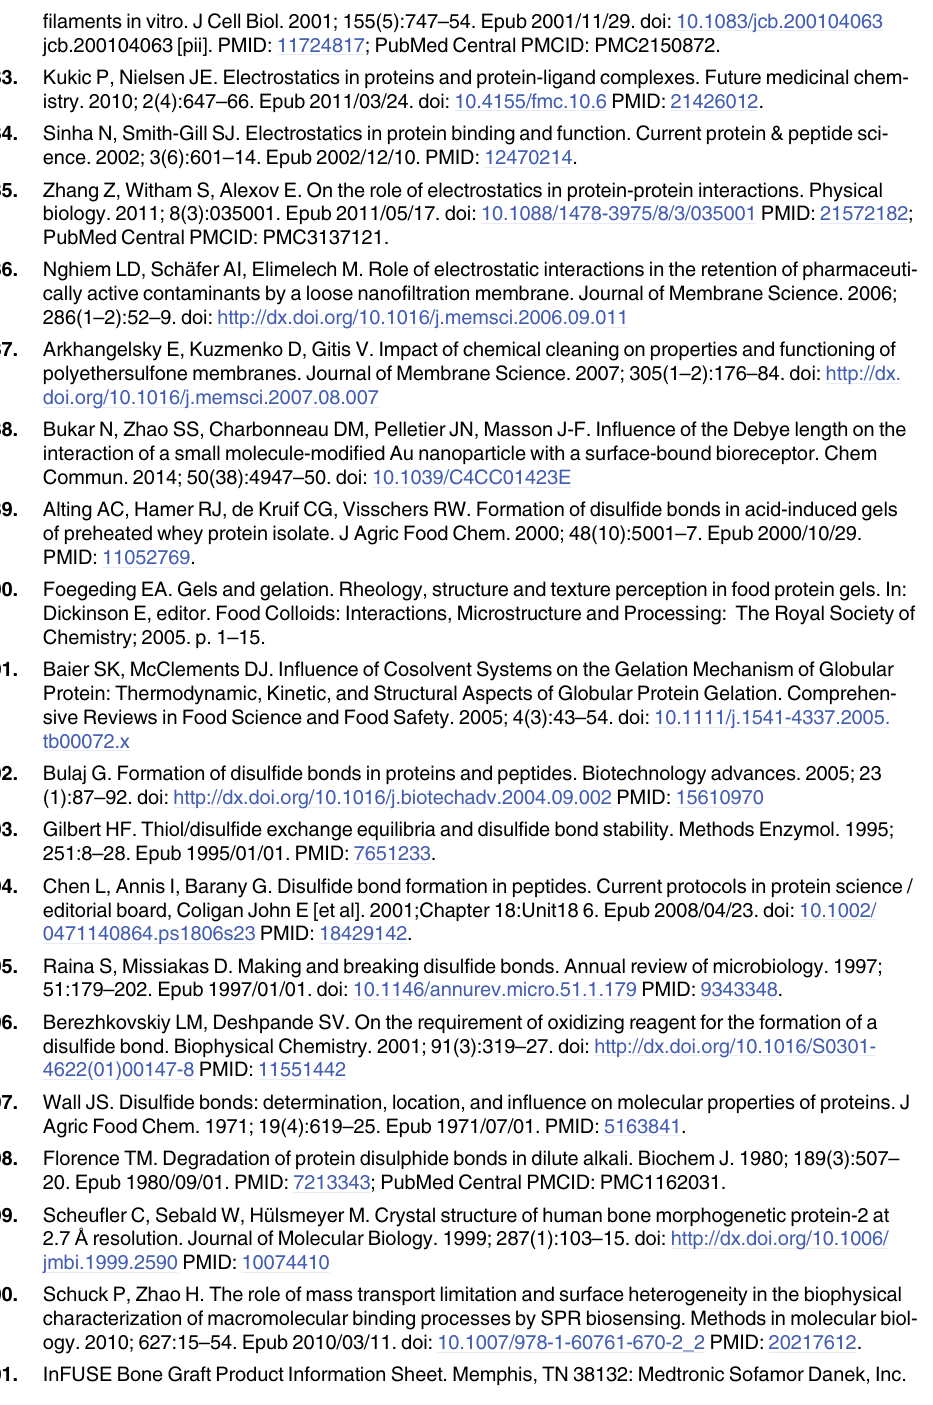
PLOS ONE | DOI:10.1371/journal.pone.0137233 August 28,